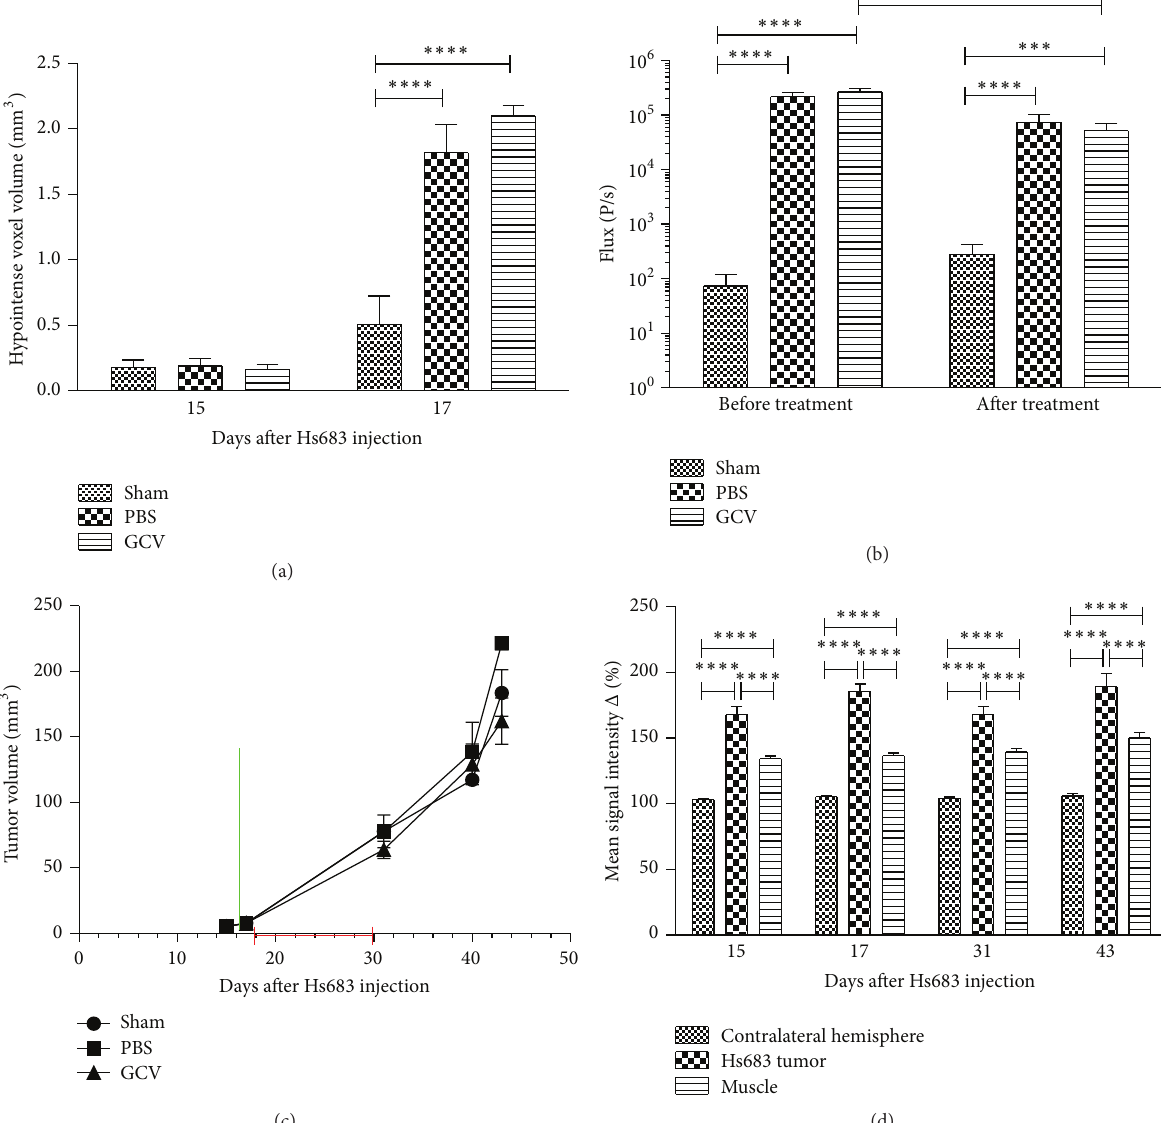
Figure 7: Quantification of in vivo imaging data to monitor suicide gene therapy using hMultistem as cellular vehicles in the Hs683 oligodendrogliomamodel.(a)QuantificationofthevolumeofhypointensevoxelsinanimalsreceivingSPIOlabeledhMultistemcellsindicates sufficient contrast to detect the therapeutic cells in the Hs683 tumor model (sham (no cells): 𝑁 = 3 , PBS treated: 𝑁 = 6 , and GCV treated: 𝑁 = 6 ). (b) Bioluminescent imaging data showed that the stem cells were detectable through BLI, but no statistically significant difference in stem cell viability between the PBS and GCV receiving animals could be detected following treatment. However, there was a small decrease in the BLI signal before and after treatment in the GCV treated group. (c) Tumor volume measurements proved no statistical differences between sham operated, PBS treated, or GCV treated animals (green bar: hMultistem injection; red bar: duration of GCV/PBS treatment). (d) T 1 -weighted MRI pre- and postcontrast injection showed BBB integrity loss in the Hs683 tumor compared to the contralateral hemisphere and the extracranial muscle at all time points ( 𝑁 = 15 ). Levels of significance are expressed as ∗ 𝑝 < 0.05 , ∗∗ 𝑝 < 0.01 , ∗∗∗ 𝑝 < 0.001 , and ∗∗∗∗ 𝑝 < 0.0001